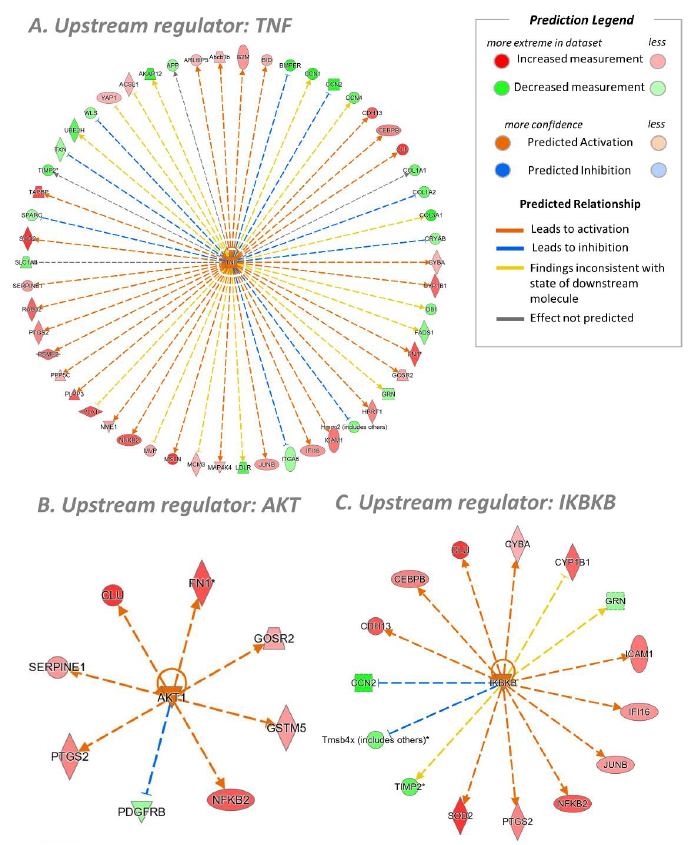
Figure 9. Upstream regulators determined in the CTR-TNF vs. CTR condition by IPA analysis (LFQ). ( A ) The wheel of proteins involved in the TNF α stimuli. ( B , C ) The wheels of proteins associated with AKT and IKBKB as upstream regulators. Above is the prediction legend (IPA) essential for understanding networks. * multiple isoforms. Regarding the CTR-TAP vs. CTR comparison, the activation of the NRF2 pathway by TAP, as already evidenced by the SILAC approach, was confirmed and the number of proteins involved in the signaling was greatly extended. Furthermore, TAP treatment was associated with a reduction in ferroptosis, apoptosis and oxidative stress (data not shown). Regarding the third group, CTR-TNF-TAP vs. CTR-TNF, the LFQ approach permit- ted a better description of the upstream regulators relative to a reduction in oxidative stress and NRF2 pathway due to the increased number of the identified proteins involved in the pathways (Figure 10).